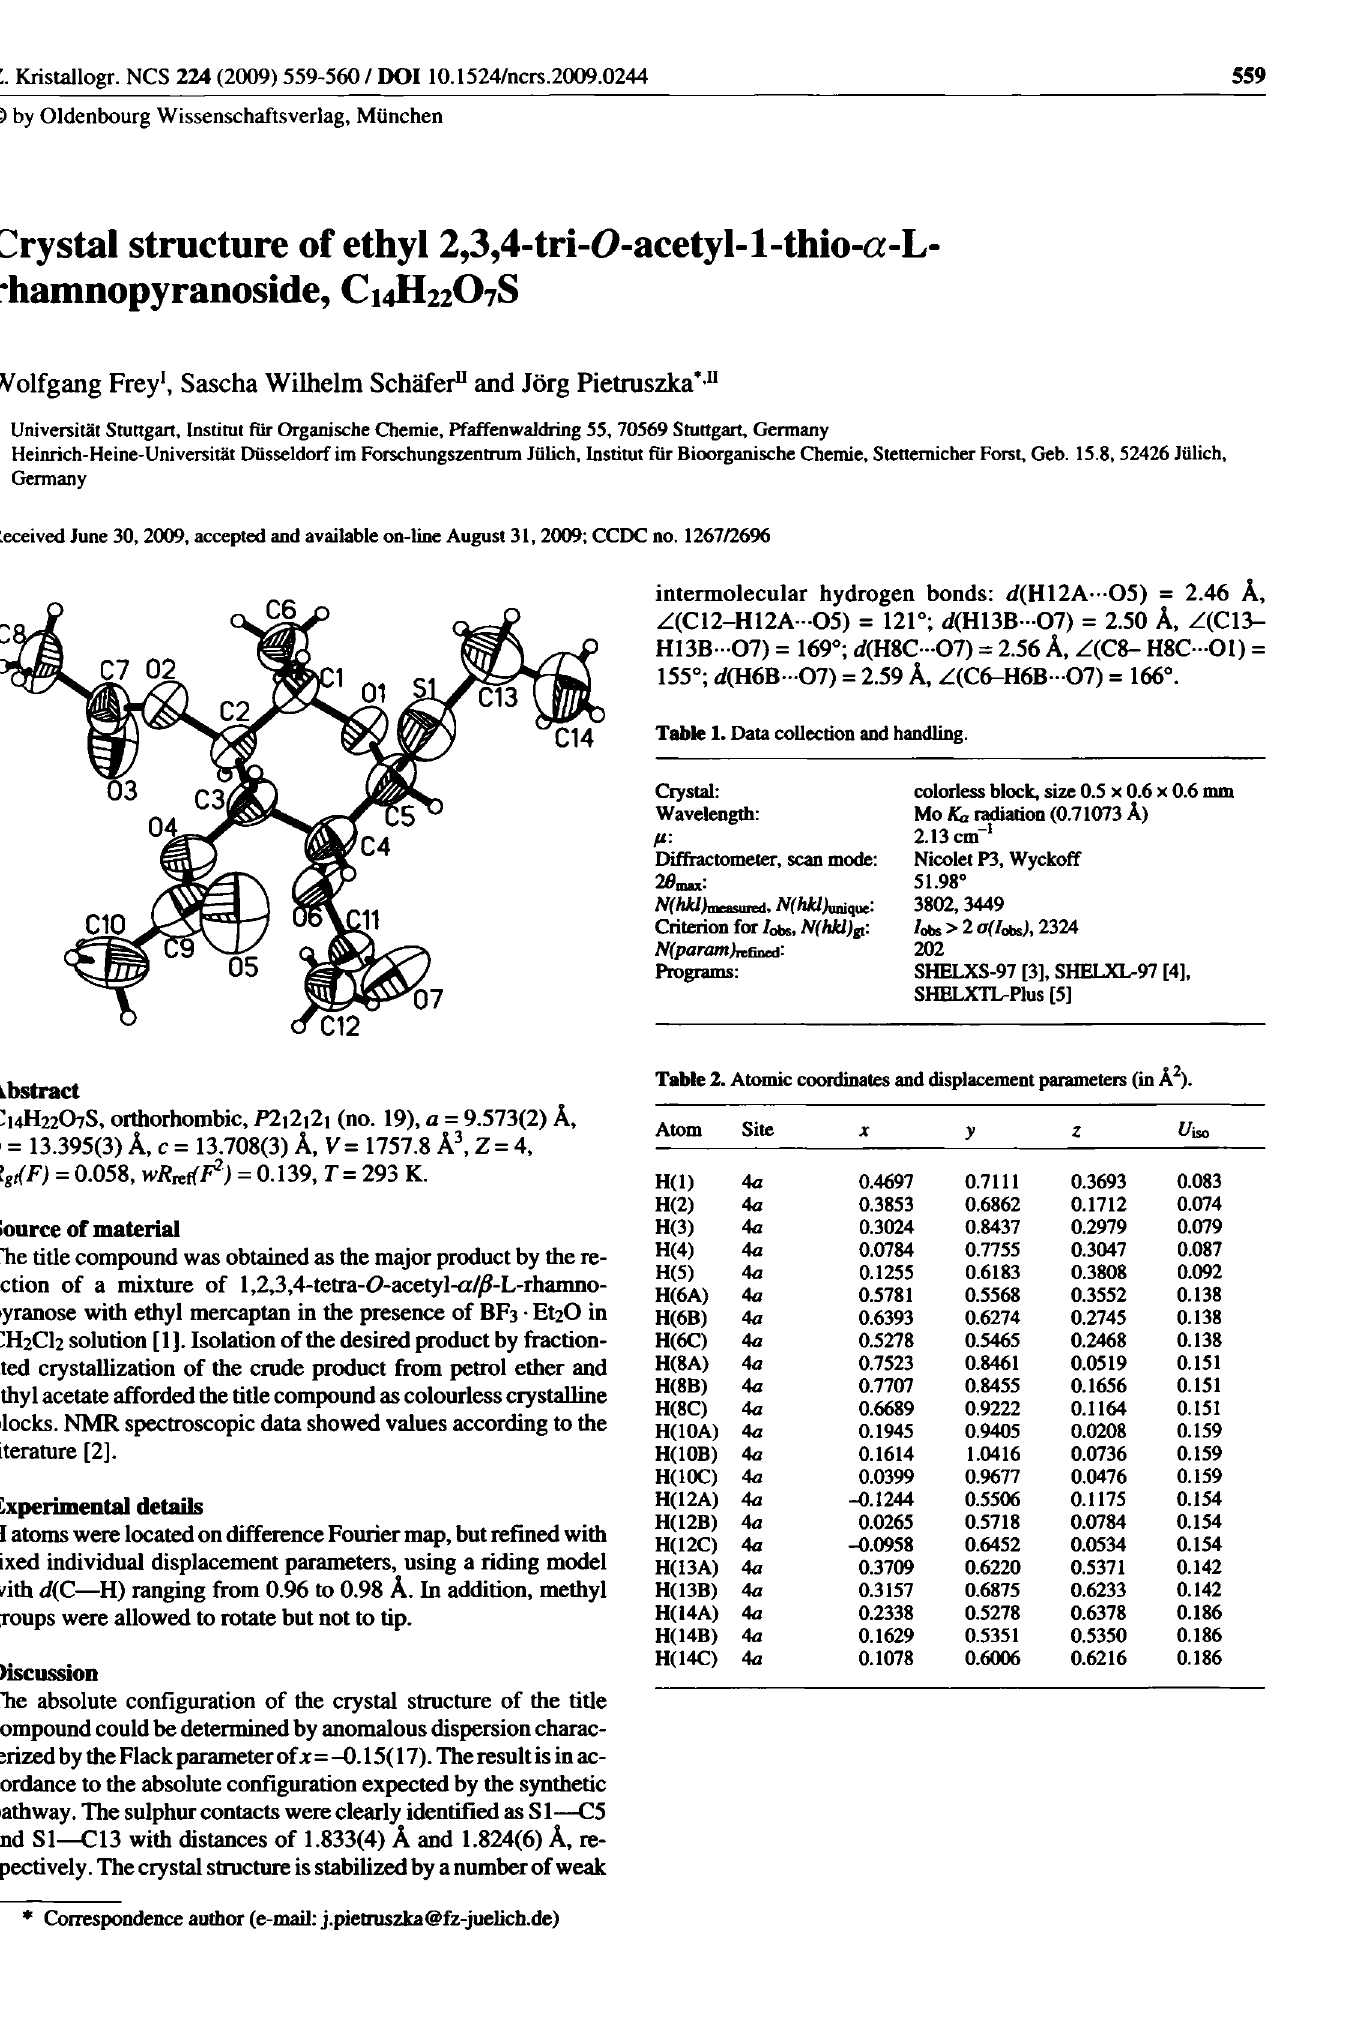
Table 2. Atomic coordinates and displacement parameters (in Â 2